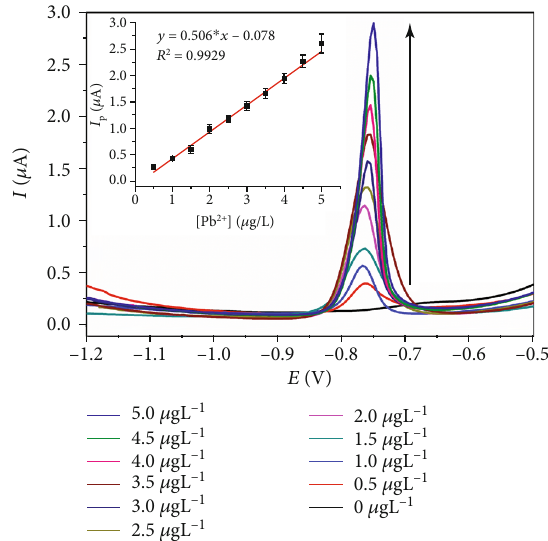
Figure 7: The SWASV response for the increasing concentration of Pb 2+ in 0.5 – 5.0 μ g · L -1 and the corresponding calibration plots (inset) of p(1,5-DAN)/SPEs. Electrolyte: acetate bu ff er (pH4.5); deposition potential: -1.2V; deposition time: 360